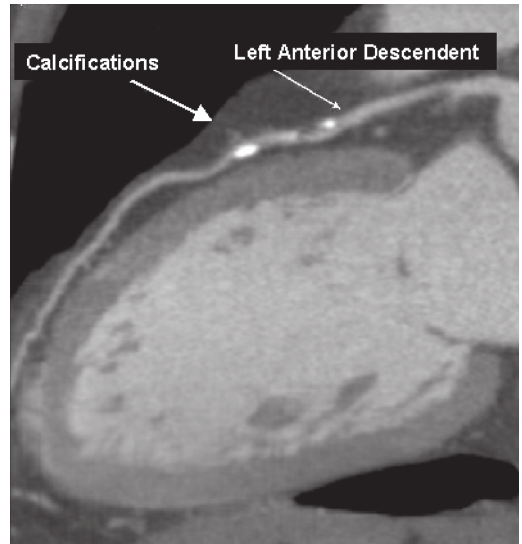
Figure 1 - Ultra fast multislice computer tomography of coronary arteries. Calcification of coronary, score 9.8 Agatston, 80 75 th percentile for age and